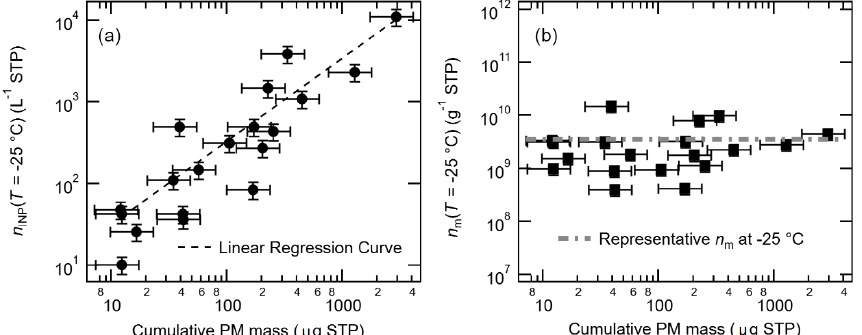
Figure 7. Correlation between cumulative PM mass vs. n INP (a) and vs. n m (b) at − 25 ◦ C; a linear regression curve in log scale ( n INP = 3.51 × cumulative PM mass − 2.41; r = 0 . 94) is shown in (a) , and the constant value of representative n m at the given tempera- ture (3.55 × 10 9 g − 1 ), which is a median n m value of minimum − maximum, is shown in (b) . Note that the errors in cumulative PM mass are ± 40 . 4%. The uncertainty in n INP and n m is ± 23 .